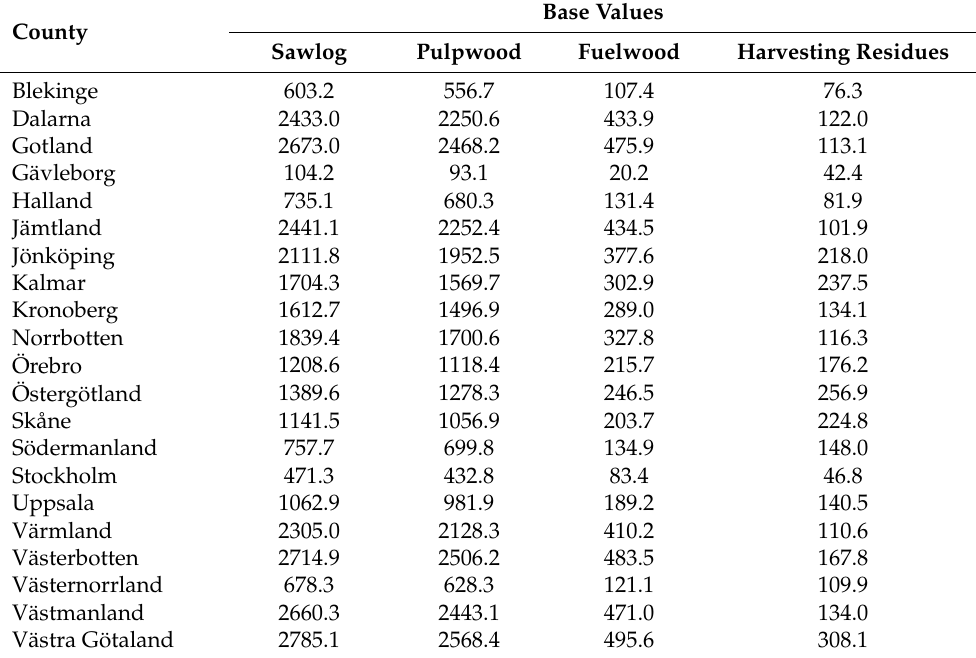
Table A7. Average DEA harvesting levels 1000 m 3 solid